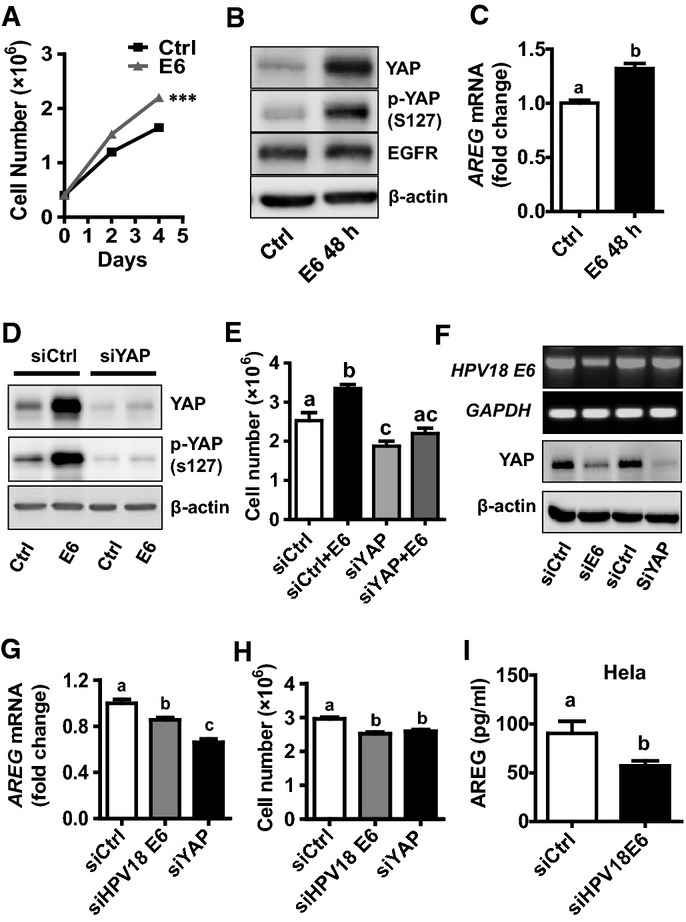
YAP is involved in HPV-E6 regulation of cervical cancer cell growth
Effect of recombinant HPV16 E6 protein on the proliferation of HT3 cells. Each point represents mean ± SEM (n = 5). ***P = 0.0001 compared with control (Ctrl) on day 4. HT3 cells were cultured in serum-reduced medium in the presence or absence of recombinant HPV16 E6 (400 nM).

Recombinant HPV16 E6 protein increased YAP protein level, but had no effect on β-actin protein level in HT3 cells. Cell culture and treatment procedure are the same as described in (A).

AREG mRNA levels in HT3 cells incubated for 48 h with or without recombinant HPV E6. Each bar represents mean ± SEM (n = 5). Bars with different letters are significantly different from each other (P = 0.0042).

Western blotting analysis showing the effect of HPV16 E6 (400 nM, 48 h) on YAP protein levels in HT3 cells transfected with non-targeting control siRNA (siCtrl) or YAP siRNA (siYAP).

Effect of YAP on HPV16 E6 stimulation of HT3 cell proliferation. siCtrl: non-targeting control siRNA; siYAP: YAP siRNA; E6: 400 nM recombinant HPV16 E6, 48 h. Each bar represents mean ± SEM (n = 4). Bars with the same letters are not significantly different from each other (siCtrl vs. siCtrl+E6, P = 0.0232; siCtrl+E6 vs. siYAP+E6, P = 0.0011).

Knockdown of endogenous E6 in HeLa cells with HPV18 E6 siRNA (siE6) reduced YAP protein in HeLa cells, while knockdown of YAP with YAP siRNA (siYAP) in these cells had no effect on the mRNA level of HPV18 E6. siCtrl: non-targeting control siRNA.

Knockdown of endogenous HPV18 E6 in HeLa cells with HPV18 E6-specific siRNA (siE6) significantly suppressed mRNA expression of AREG. Each bar represents mean ± SEM (n = 4). Bars with different letters are significantly different from each other (siCtrl vs. siHPV18E6, P = 0.0181; siCtrl vs. siYAP, P = 0.0005).

Knockdown of endogenous HPV18 E6 in HeLa cells with HPV18 E6-specific siRNA (siE6) significantly suppressed cell growth (n = 9, siCtrl vs. siHPV18E6, P = 0.0002; siCtrl vs. siYAP, P = 0.0004).

Concentrations of AREG in the culture medium of HeLa cells transfected with non-targeting control siRNA (siCTRL) or HPV18 E6 siRNA (siHPV18E6). Each bar represents mean ± SEM (n = 6). Bars with different letters are significantly different from each other (P = 0.0461).
Data information: Quantitative data in (A), (C), and (I) were analyzed for significance using unpaired t-test in GraphPad Prism 5 with Welch’s correction. Data in (E), (G), and (H) were analyzed for significance using one-way ANOVA in GraphPad Prism 5 with Tukey’s post hoc tests.